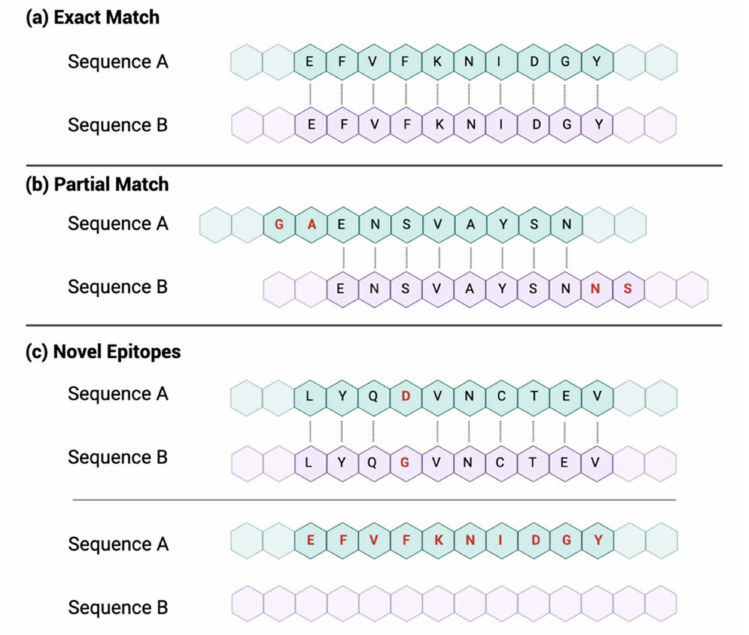
Figure 3. CAVES matching criteria. ( a ) An exact match occurs when two epitopes have identical amino acid characters over the entire length of at least one of the two epitopes being compared. ( b ) A partial match occurs when two epitopes have some identical amino acid characters but not enough to cover the full length of either epitope. ( c ) Novel epitopes occur either when two epitopes form an exact or partial match but contain a mutation (substitution, insertion, or deletion) in at least one position or when an epitope did not find any match in the opposing